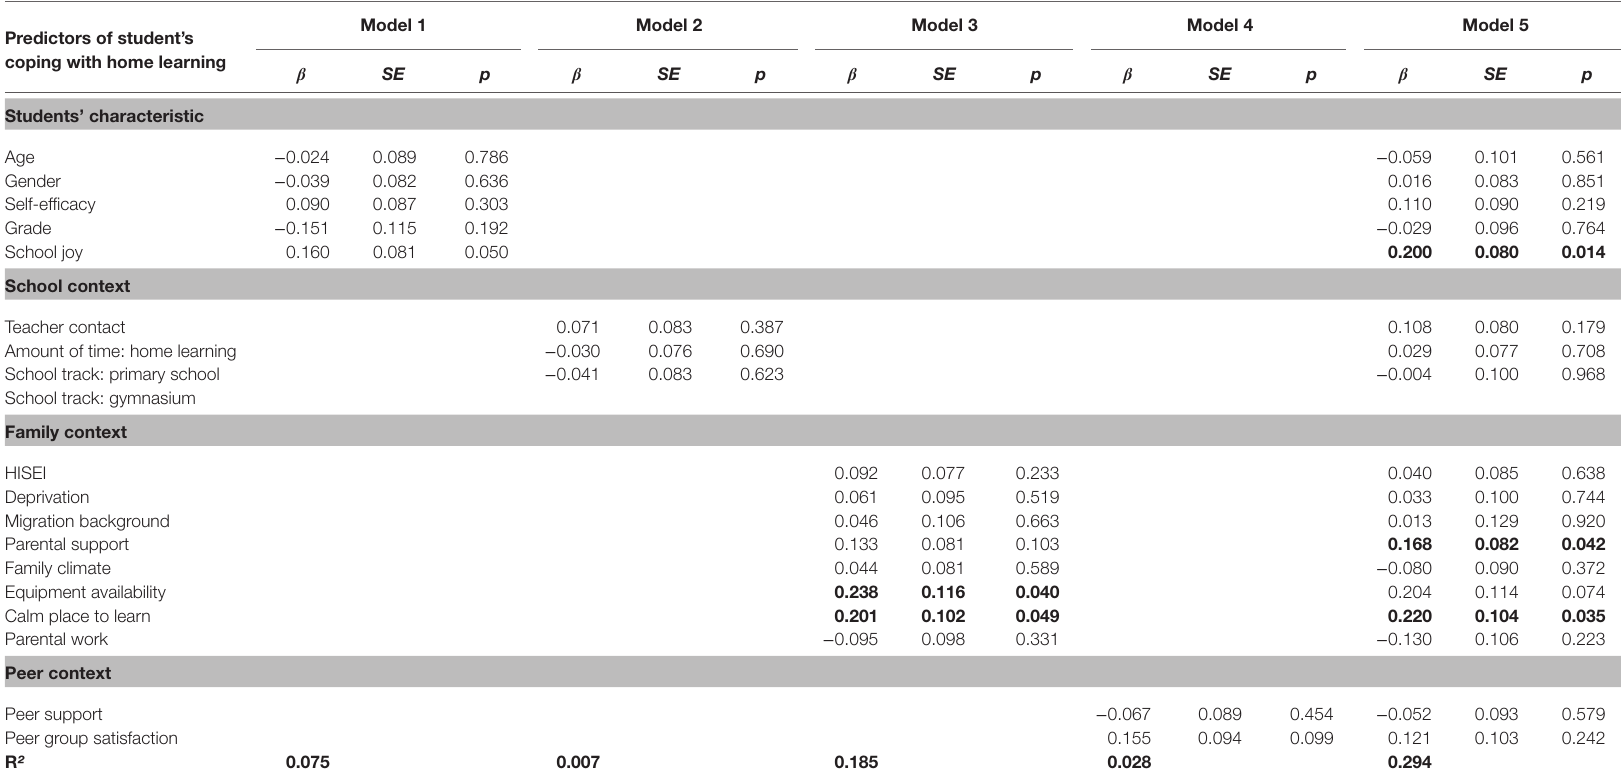
TABLE 2 | Individual and contextual predictors of children’s self-perceived coping success with home learning. Predictors of student’s coping with home